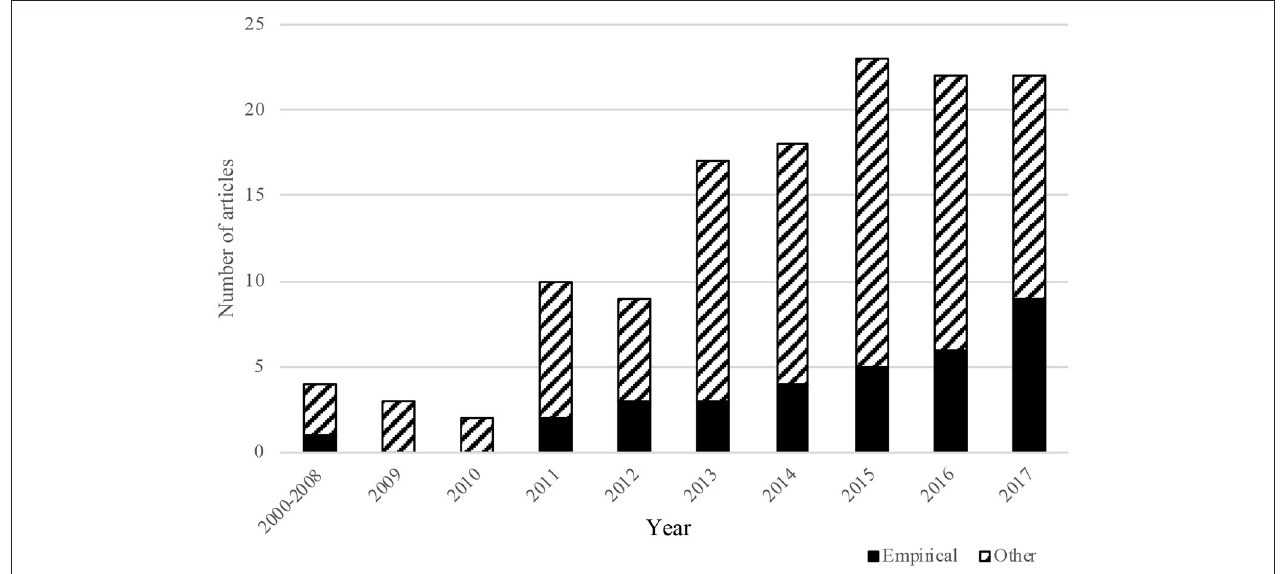
FIGURE 1 | Results of literature search for case studies of transformational adaptation in agriculture driven at least in part by a changing climate, showing number of articles by